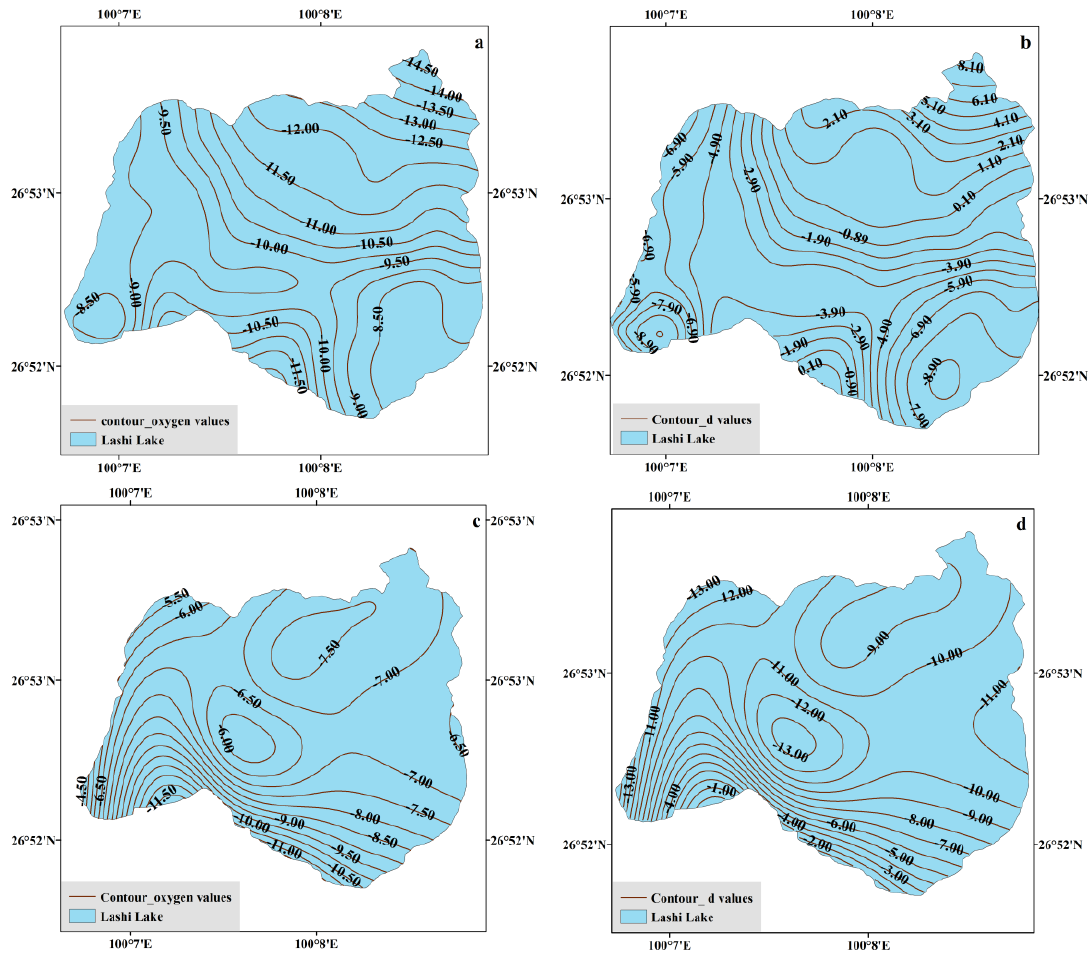
Figure 4. Contoured variations of oxygen isotope composition and deuterium excess value in August and April. ( a , b ) stand for the spatial variation of oxygen isotope and d-excess value in August; ( c , d ) stand for the spatial variation of oxygen isotope and d-excess value in April. The diagram was established using “Spline function” as the method of interpolation and extracting contour.